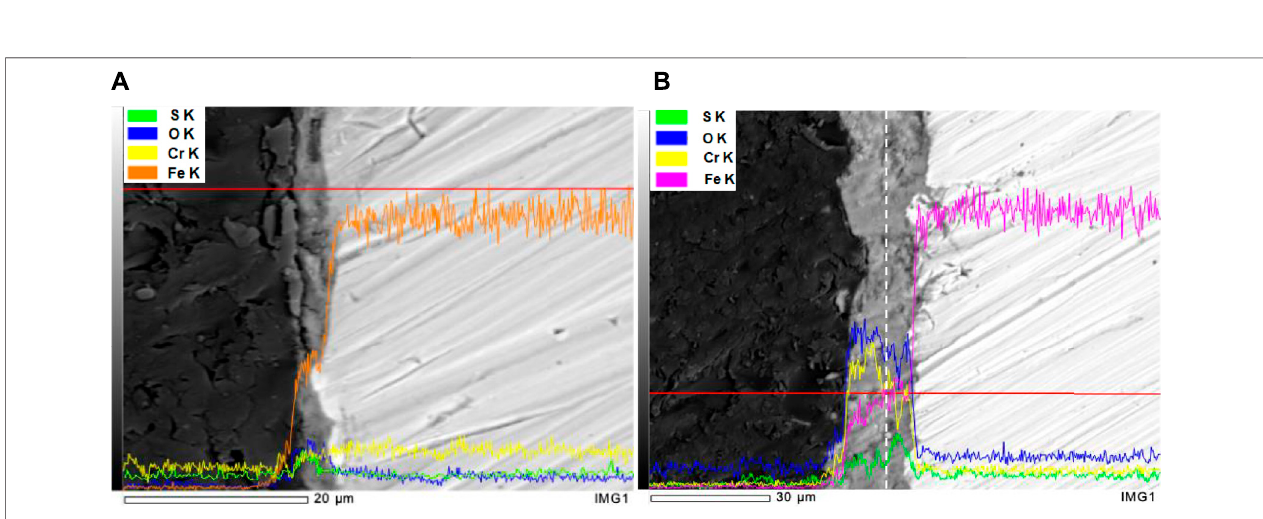
FIGURE 7 | Cross section of the corrosion scale formed on S13Cr SS exposed to the formate fl uid in (A) N 2 and (B) saturated CO 2 after 120 h at 180 ° C.